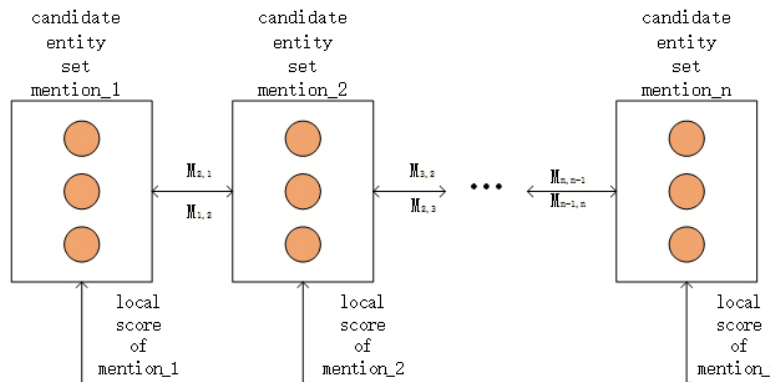
Figure 6. The framework of our global model, where each circle denotes a candidate entity. The global score is defined by transmission score and local score. Here, the local score can be computed as in Section 4.2, and we employ a Forward-Backward Algorithm to compute the transmission score which denotes the coherence among